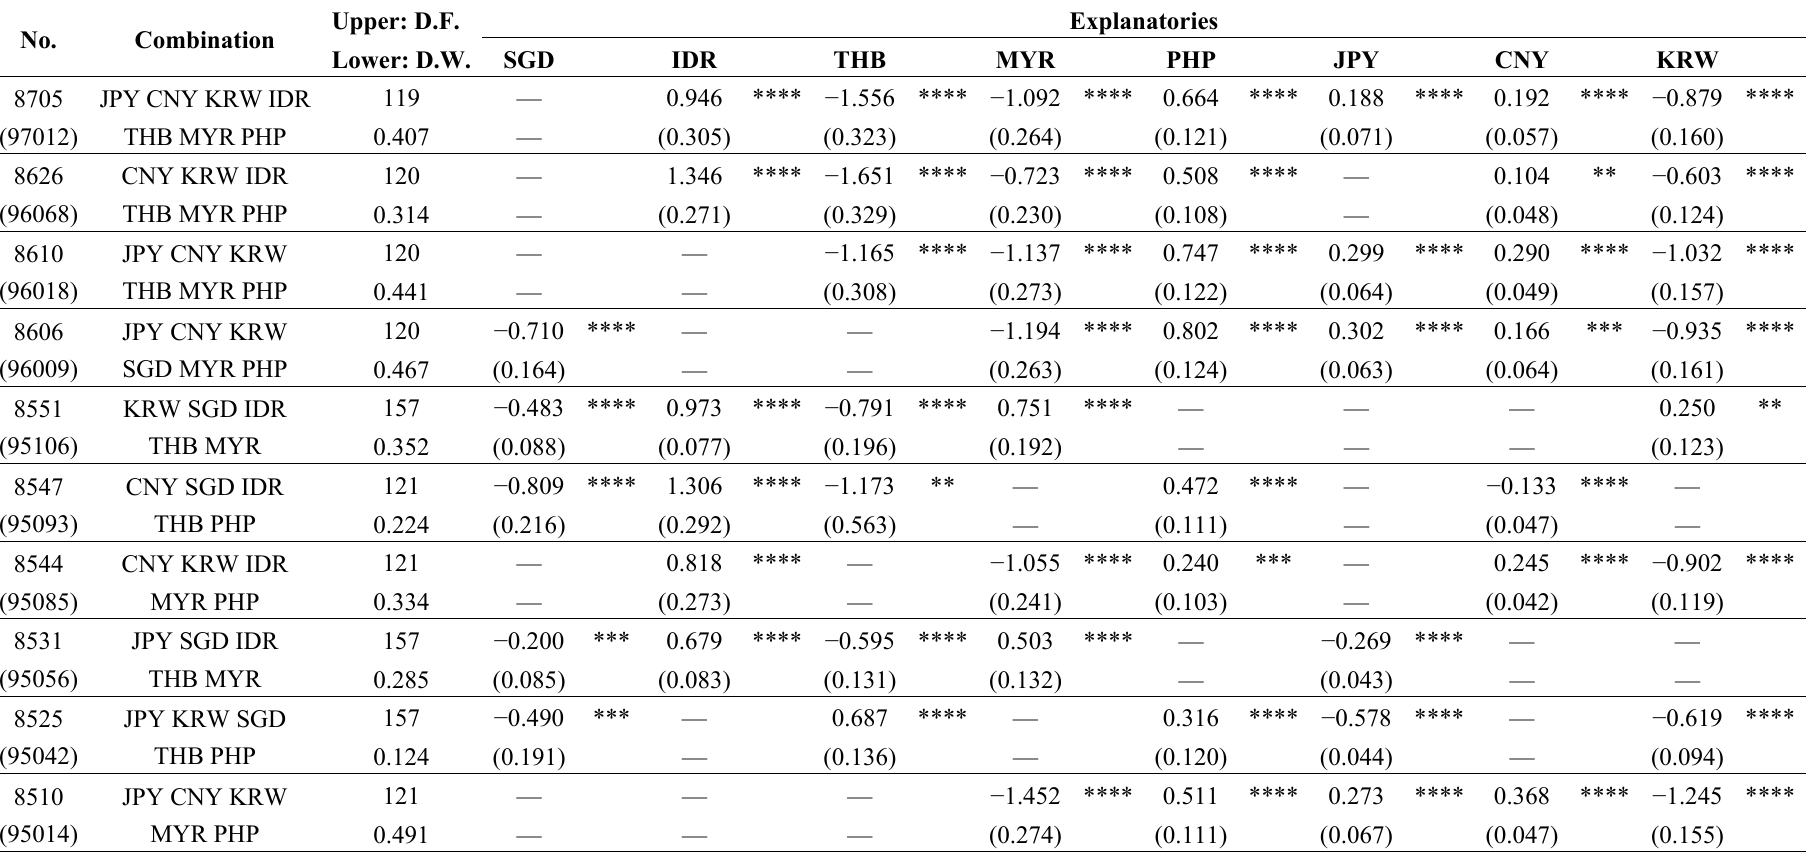
Table 3. OLS Estimation for Asymmetric Integration (January 1984–June